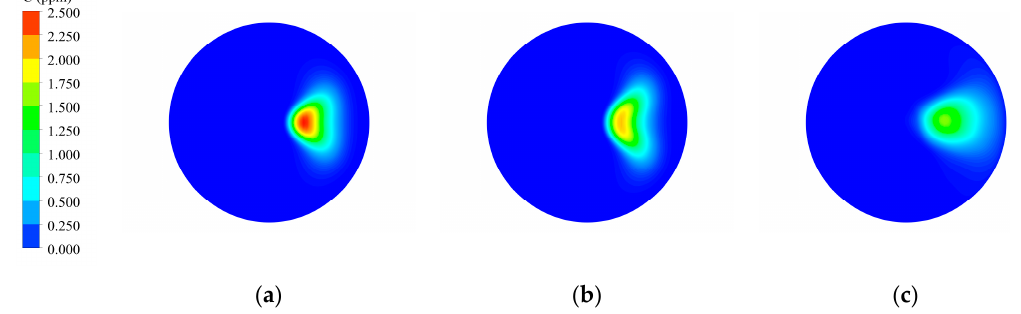
Figure 16. Comparisons of the pollutant concentration distribution at exit plane of cooling tower: ( a ) RANS; ( b ) URANS; ( c ) LES.